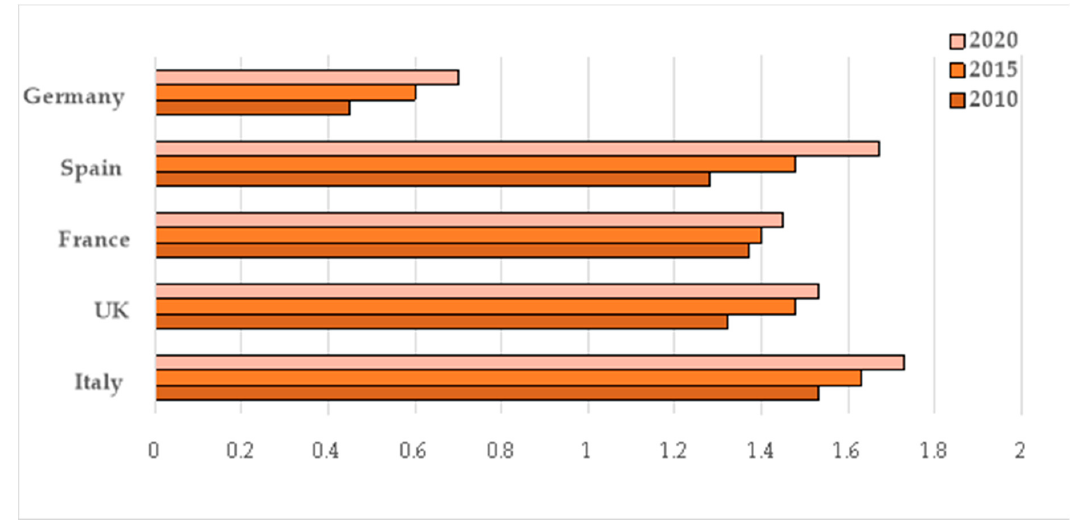
Figure 2. Per capita consumption of salad crops (data expressed as kg/year) [19].